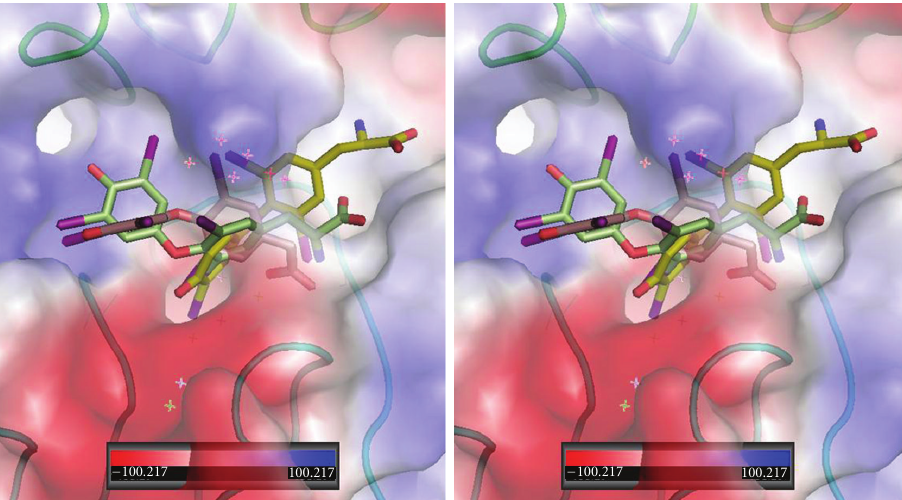
Figure 8: Stereoview of QM/MM model for T 3 (gold, Ca2), T 4 ac (beige, Ca1), and T 4 (green, Ca1) bound in α v β 3 integrin at the RGD binding site. The electrostatic surface for integrin is shown. Red is negative and blue is positive surface. α v domain is green and β 3 domain is cyan. Figure drawn with PyMol.